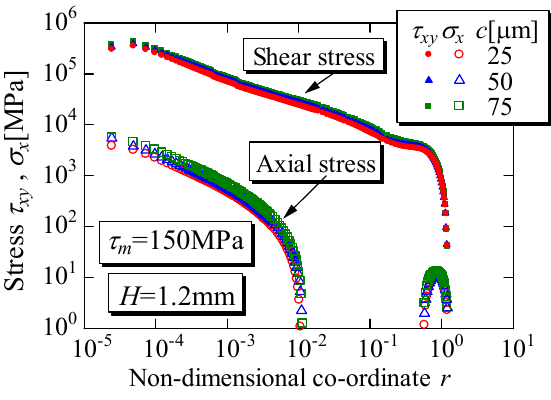
Figure 16. Effects of contact position c on stress distributions under constant average shear stress condition of τ m = 150 MPa for the specimen with H = 1.2